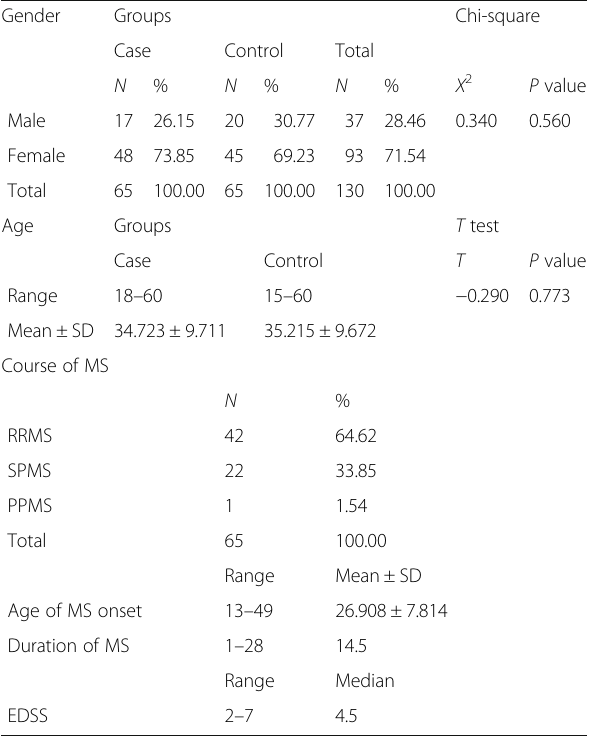
Table 1 Descriptive statistics of the study